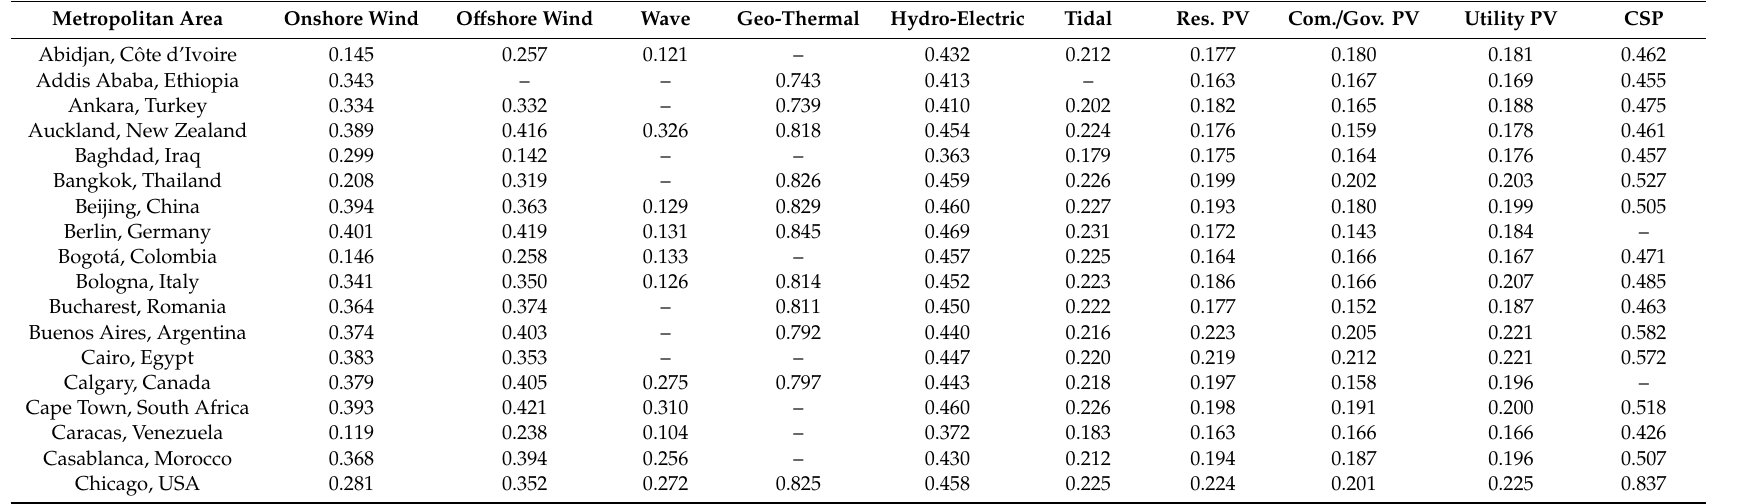
Table 5. 2050 product of capacity factor and transmission / distribution e ffi ciency for each energy generating technology and metropolitan area. Values are derived for each country in [33]. Capacity factors for onshore and o ff shore wind account for the competition among wind turbines for limited kinetic energy (array losses). A “–” indicates no installed